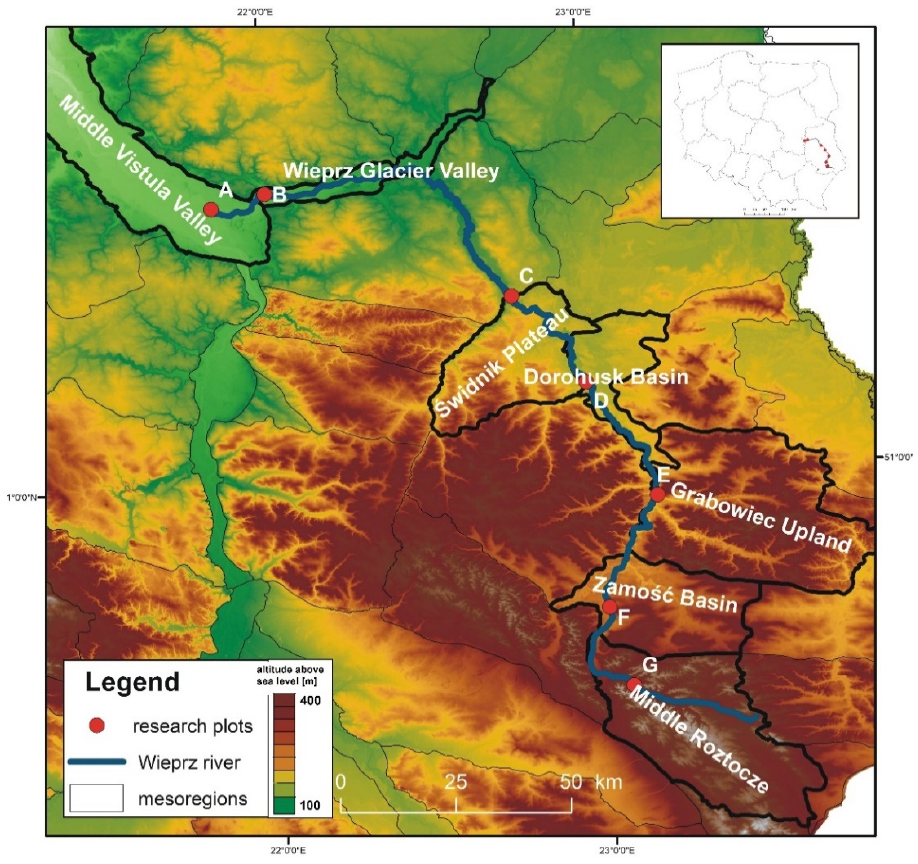
Figure 2. Location of the research plots (A – G). The Wieprz River is indicated by the blue line. Based on geoportal.gov.pl